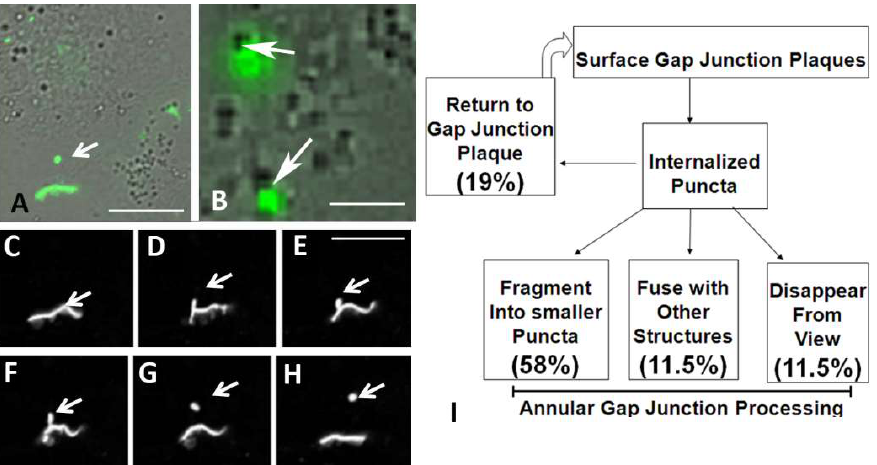
Figure 2. Time-lapse imaging of transfected cells expressing Cx43-GFP. ( A , B ) Differential interference contrast (DIC)/fluorescein isothiocyanate (FITC) overlay images of cell populations expressing Cx43-GFP. ( A ) An annular gap junction vesicle (arrow) and gap junction plaque (green) are evident. ( B ) Annular gap junctions (green) that were in contact with unidentified dense cytoplasmic structures (arrows) can be seen. ( C – H ) Montage of selected Time-lapse images collected at 1 min intervals. The gap junction plaque between two cells is evident as well as the cytoplasmic annular gap junction (arrows, ( G , H )). The invagination of the gap junction plaque (arrows, ( C – F )) and the subsequent release of an annular gap junction vesicle into the cytoplasm of one of the two contacting cells could be followed over time and the cell morphology appreciated by the DIC/FITC over lay image ( A ). ( I ) Flow chart summary of Time-lapse observations depicting annular gap junction formation and behavior. Scale Bars ( A – H ): 10 µm.